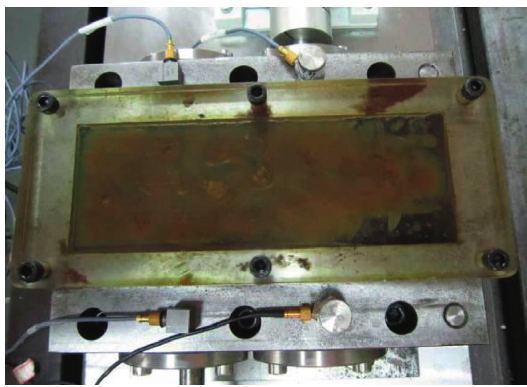
Figure 14: Diagram of sensor installation. Table 2: Combination type of multiple faults of gearbox.